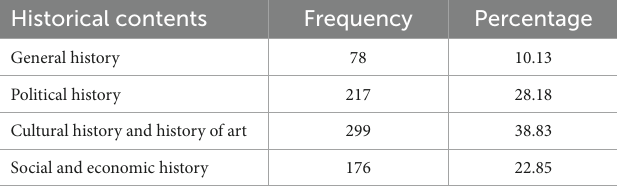
TABLE 8 The type of historical contents contained in textbook activities on the Early Modern Age (2nd year of secondary education).